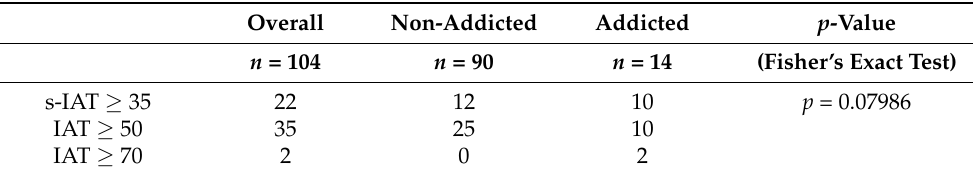
Table 2. The number of the subjects who scored more highly than each cut-off in non-addicted and addicted groups. Overall Non-Addicted